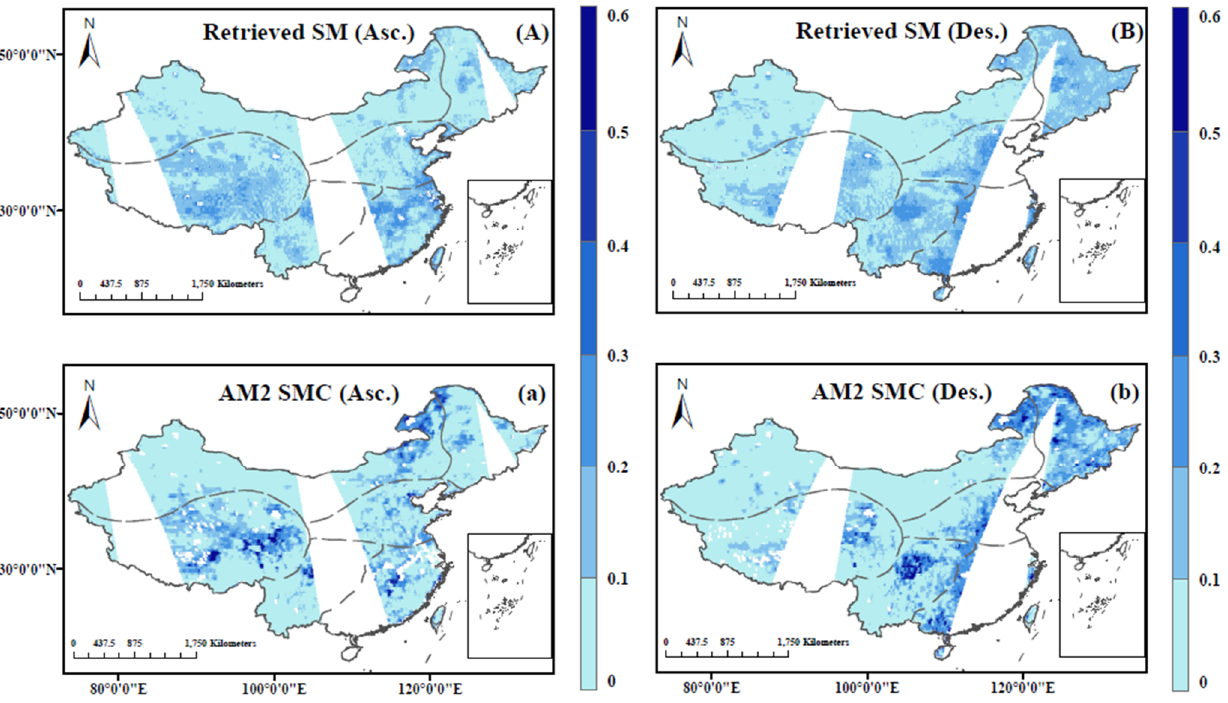
Figure 5. The retrieved SM (m 3 /m 3 ) by “MDK-CR” method: ( A ) ascending and ( B ) descending orbits. AMSR2 SM products: ( a )ascending and ( b ) descending orbits.